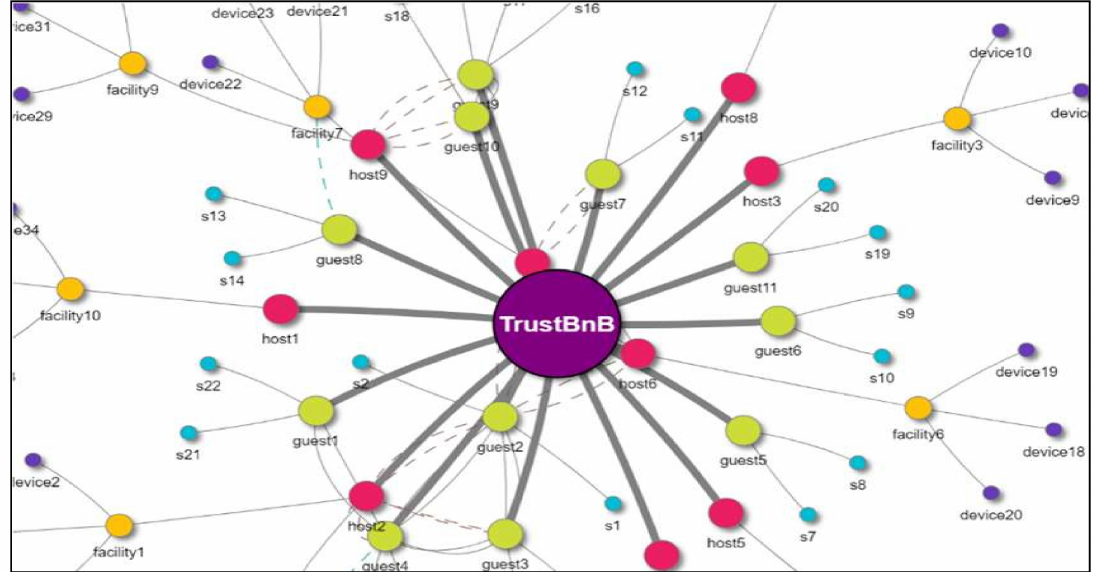
Figure 6. Trust visualization for trust relationship